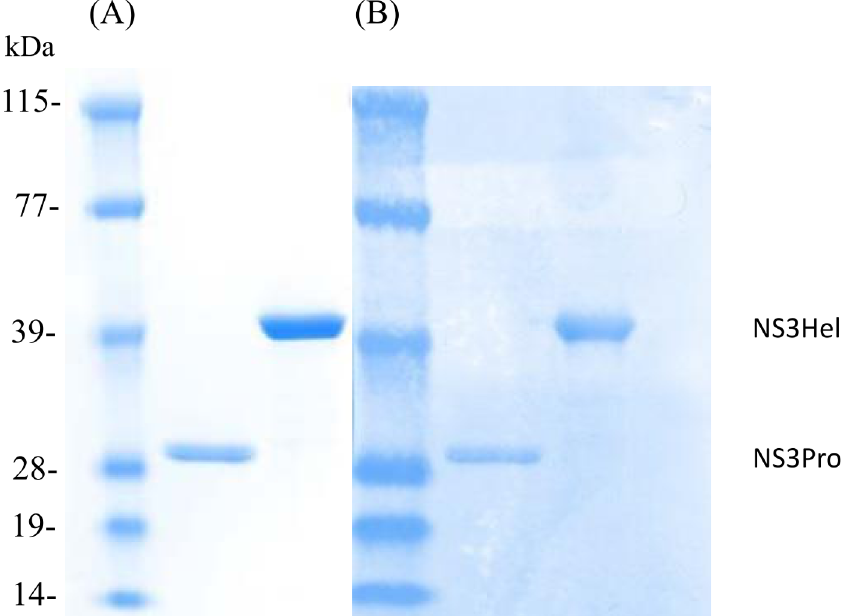
Fig 2. Purification and immunodetection of the recombinant NS3Pro and NS3Hel. Conditions for growth of E . co li transformed by the His-tagged expression plasmids and purification by metal affinity are described under Materials and Methods. The purified proteins were fractionated by SDS-PAGE (4 – 12%) and the gel was stained by Coomassie blue (A), and anti-DENV-2 HMAF was used for the Western blot (B). Lane 1, molecular size marker; lane 2, NS3Pro; lane 3, NS3Hel. Pro = protease, Hel =